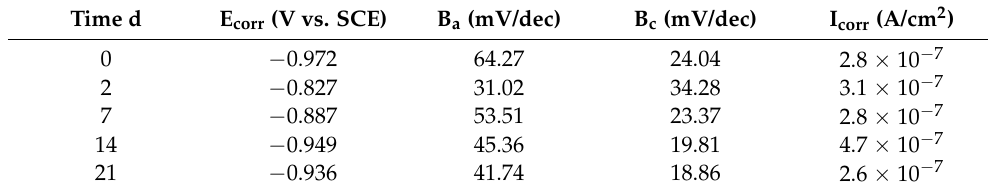
Table 2. Polarization parameters of MLDHs for different immersion